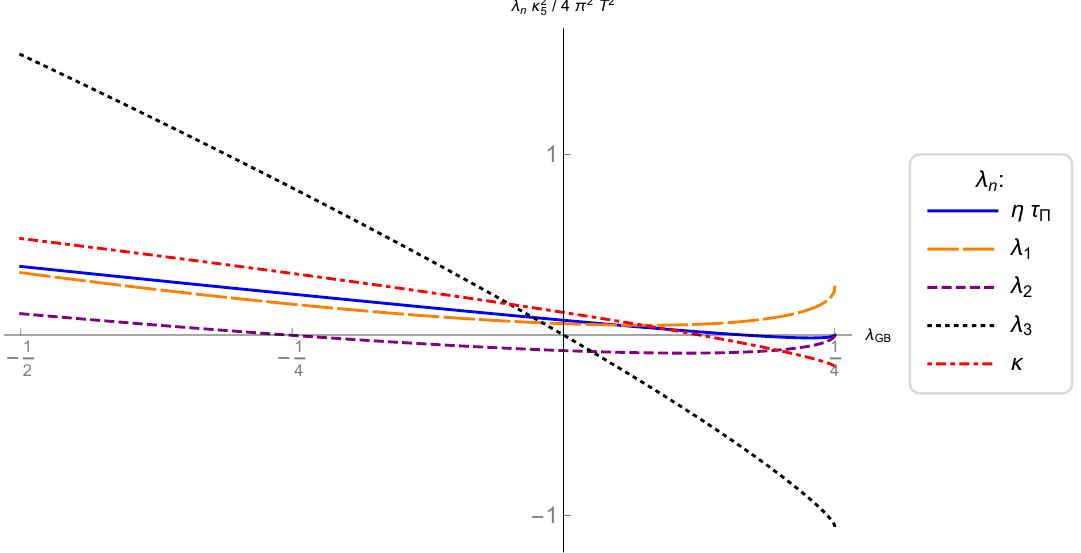
Figure 2 . Second-order coe(cid:14)cients (cid:21) n = f (cid:17)(cid:28) (cid:5) ; (cid:21) 1 ; (cid:21) 2 ; (cid:21) 3 ; (cid:20) g of Gauss-Bonnet holographic liquid, in units of 4 (cid:25) 2 T 2 =(cid:20) 2 , as functions of (cid:21) . 5 GB The derivatives of the coe(cid:14)cients with respect to (cid:21) are shown in (cid:12)gure 3. GB